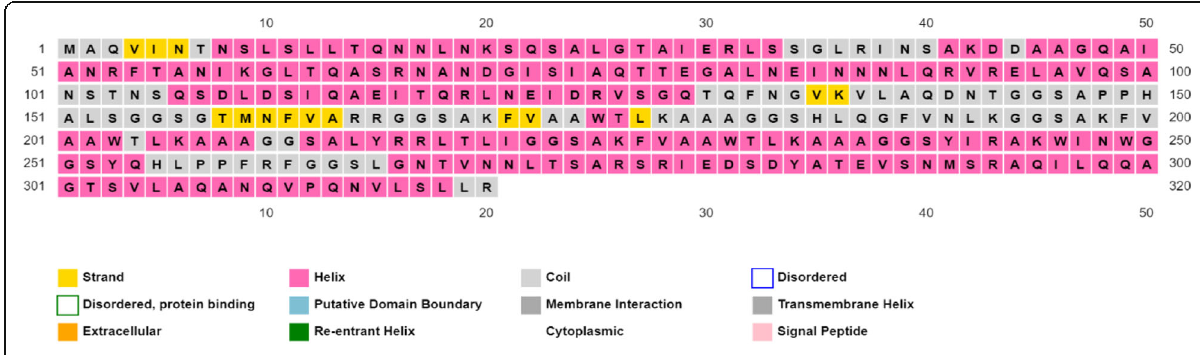
Fig. 3 Full-fledged vaccine sequence and secondary structure description